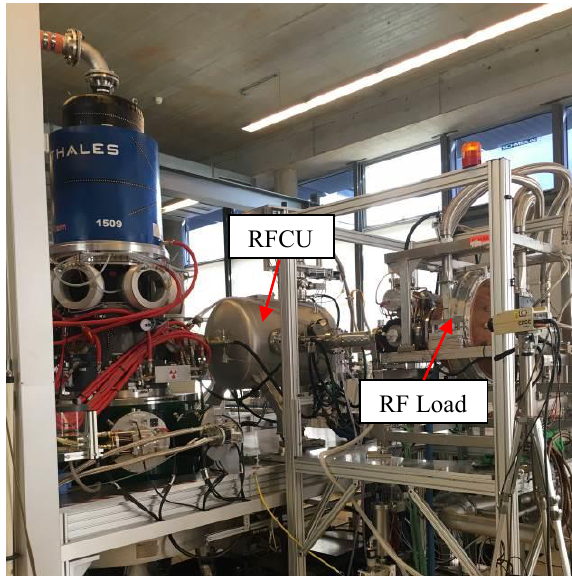
Fig. 9. The EU 1MW, 170 GHz CW industrial prototype gyrotron installed at the SPC superconducting magnet. The gyrotron is connected to the RF load using an RFCU under